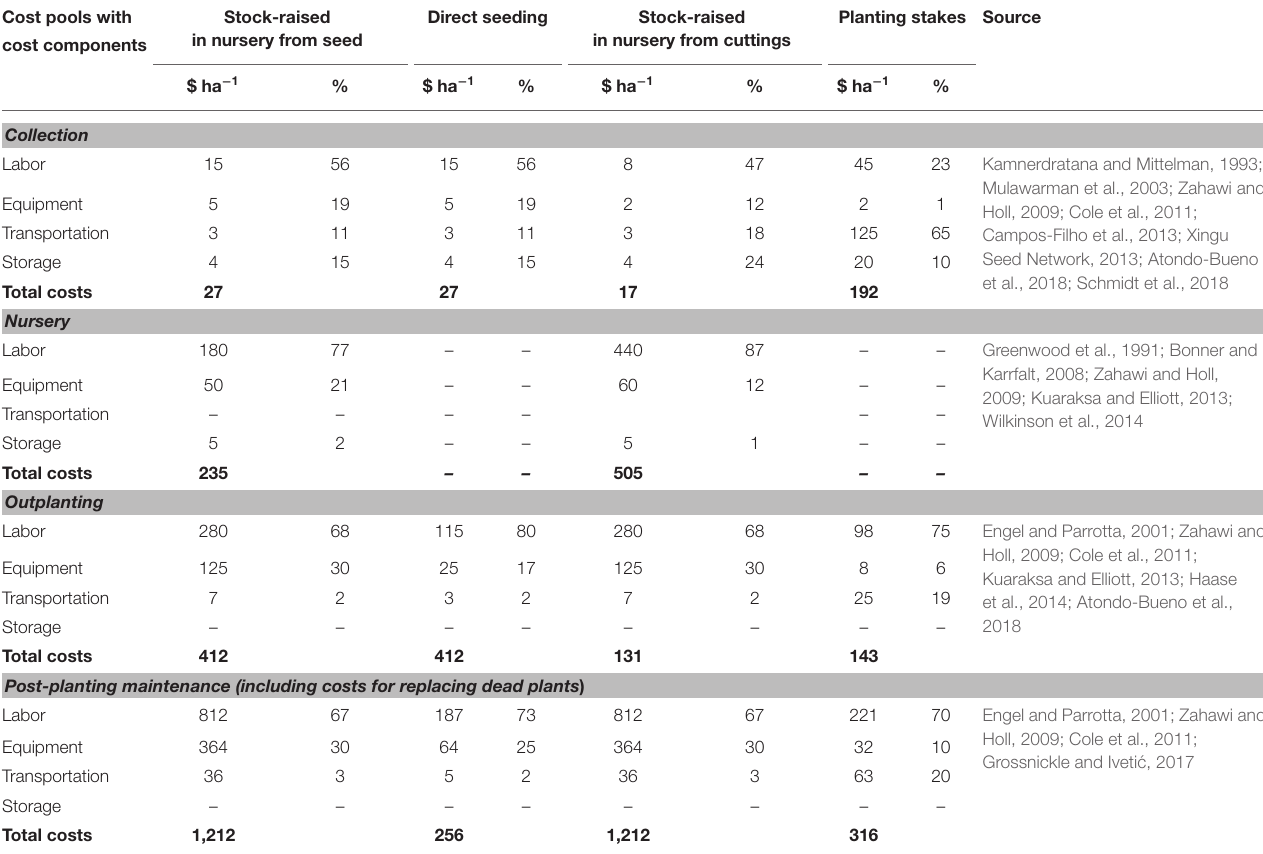
TABLE 3 | Cost estimates (in USD) for different cost components of different cost pools. Cost pools with Stock-raised Direct seeding Stock-raised Planting stakes in nursery from seed in nursery from cuttings